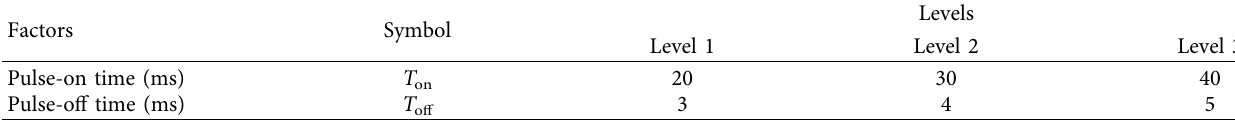
Table 4: Design factors and their levels.